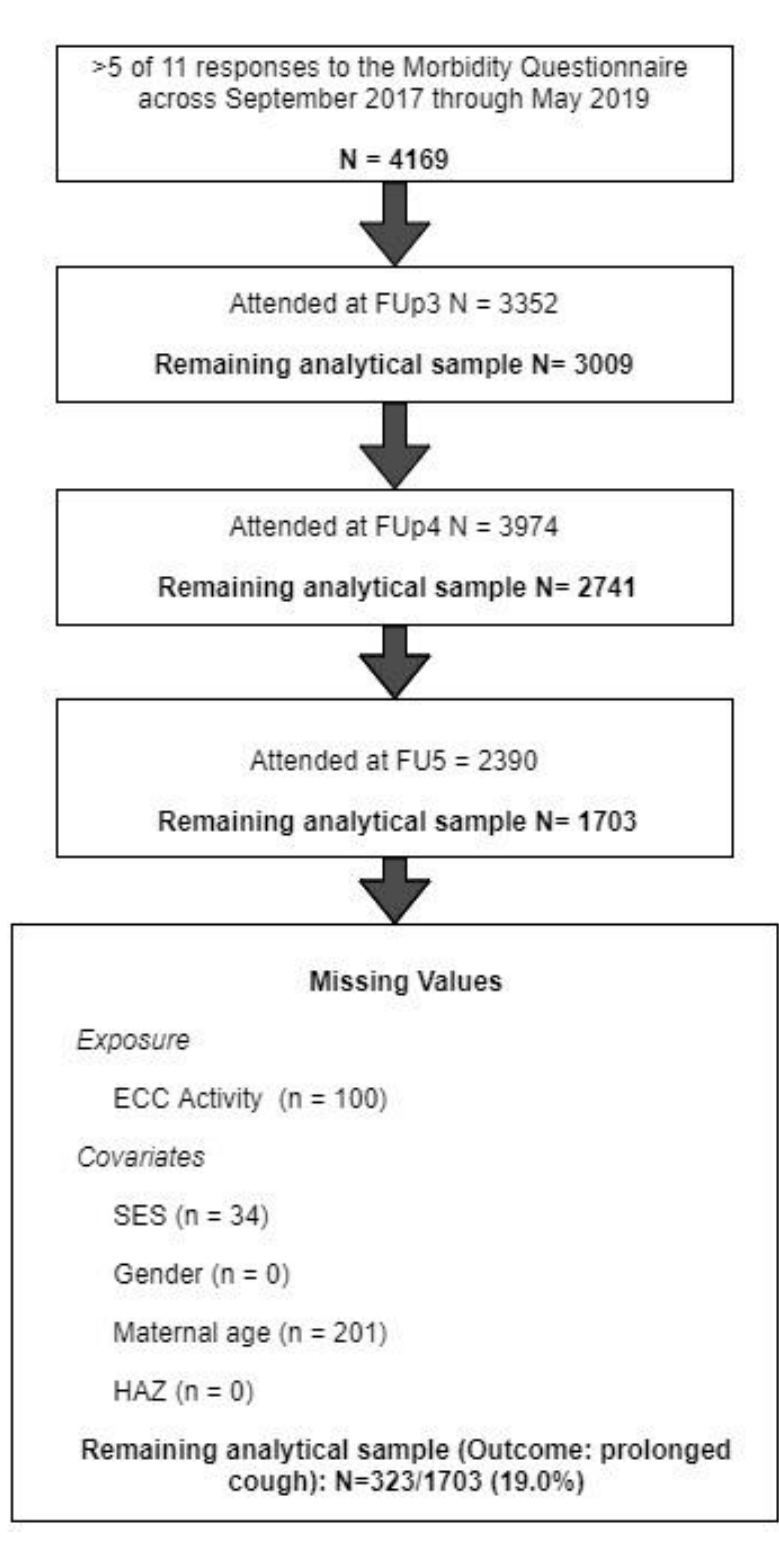
Figure 1. Analytical Sample. Abbreviations; FUp = Follow-up; N = Number of participants; SES = Socioeconomic status; HAZ = Height for Age Z-score; 14d = 14 days.